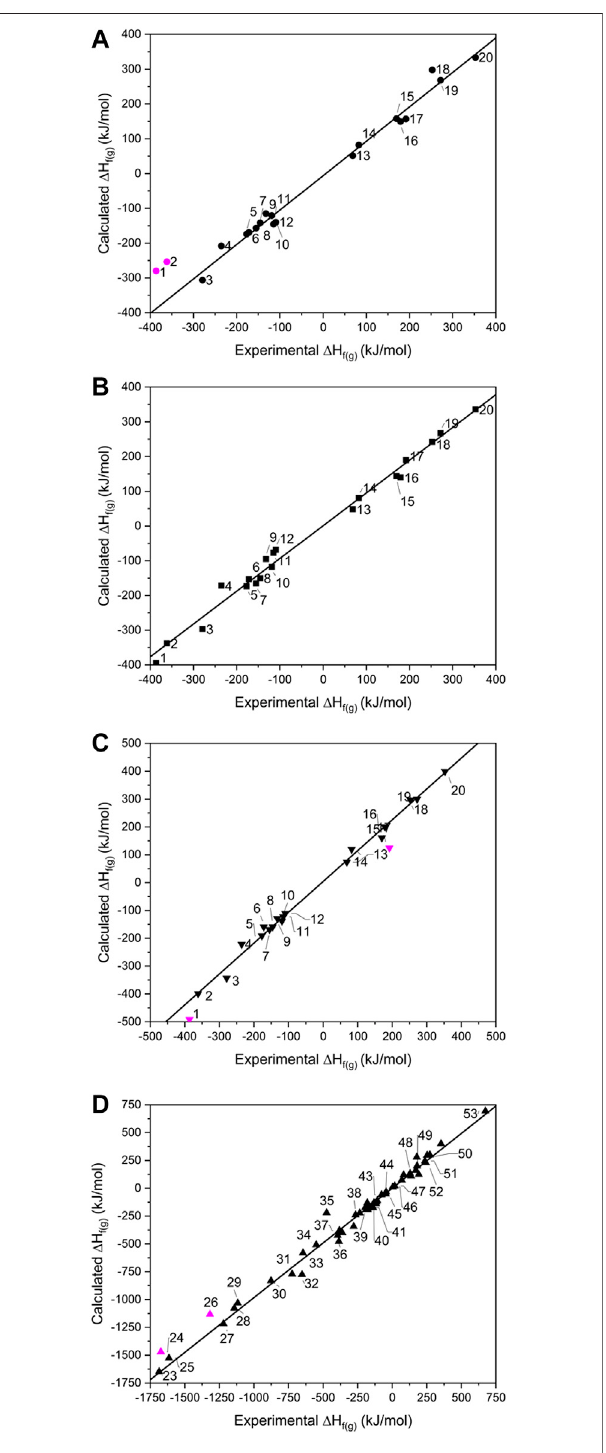
FIGURE 2 | Showing calculated vs. experimental gas phase heats of formation for the (A) isodesmic, (B) atom equivalence, (C) PM7 for 1 – 20 and (D) PM7 for 23 – 53 . Data points omitted from the lines of best fi t are shown in pink.